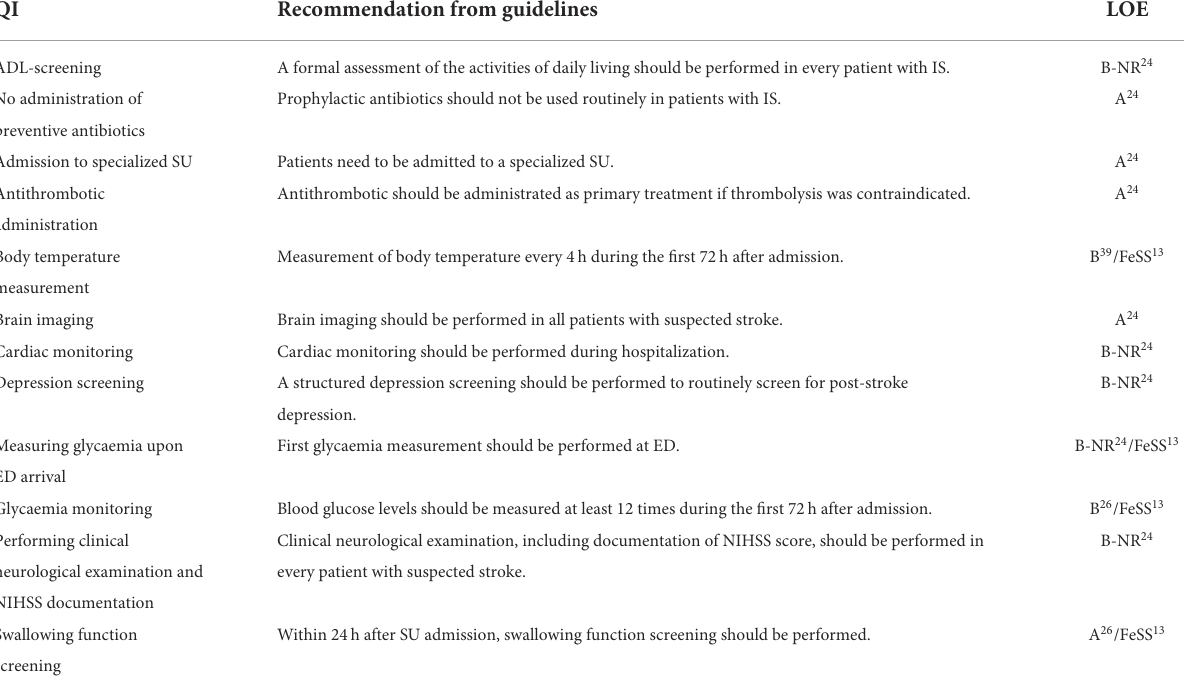
TABLE 1 Selected QI with corresponding recommendation from guidelines and level of evidence (LOE). QI Recommendation from